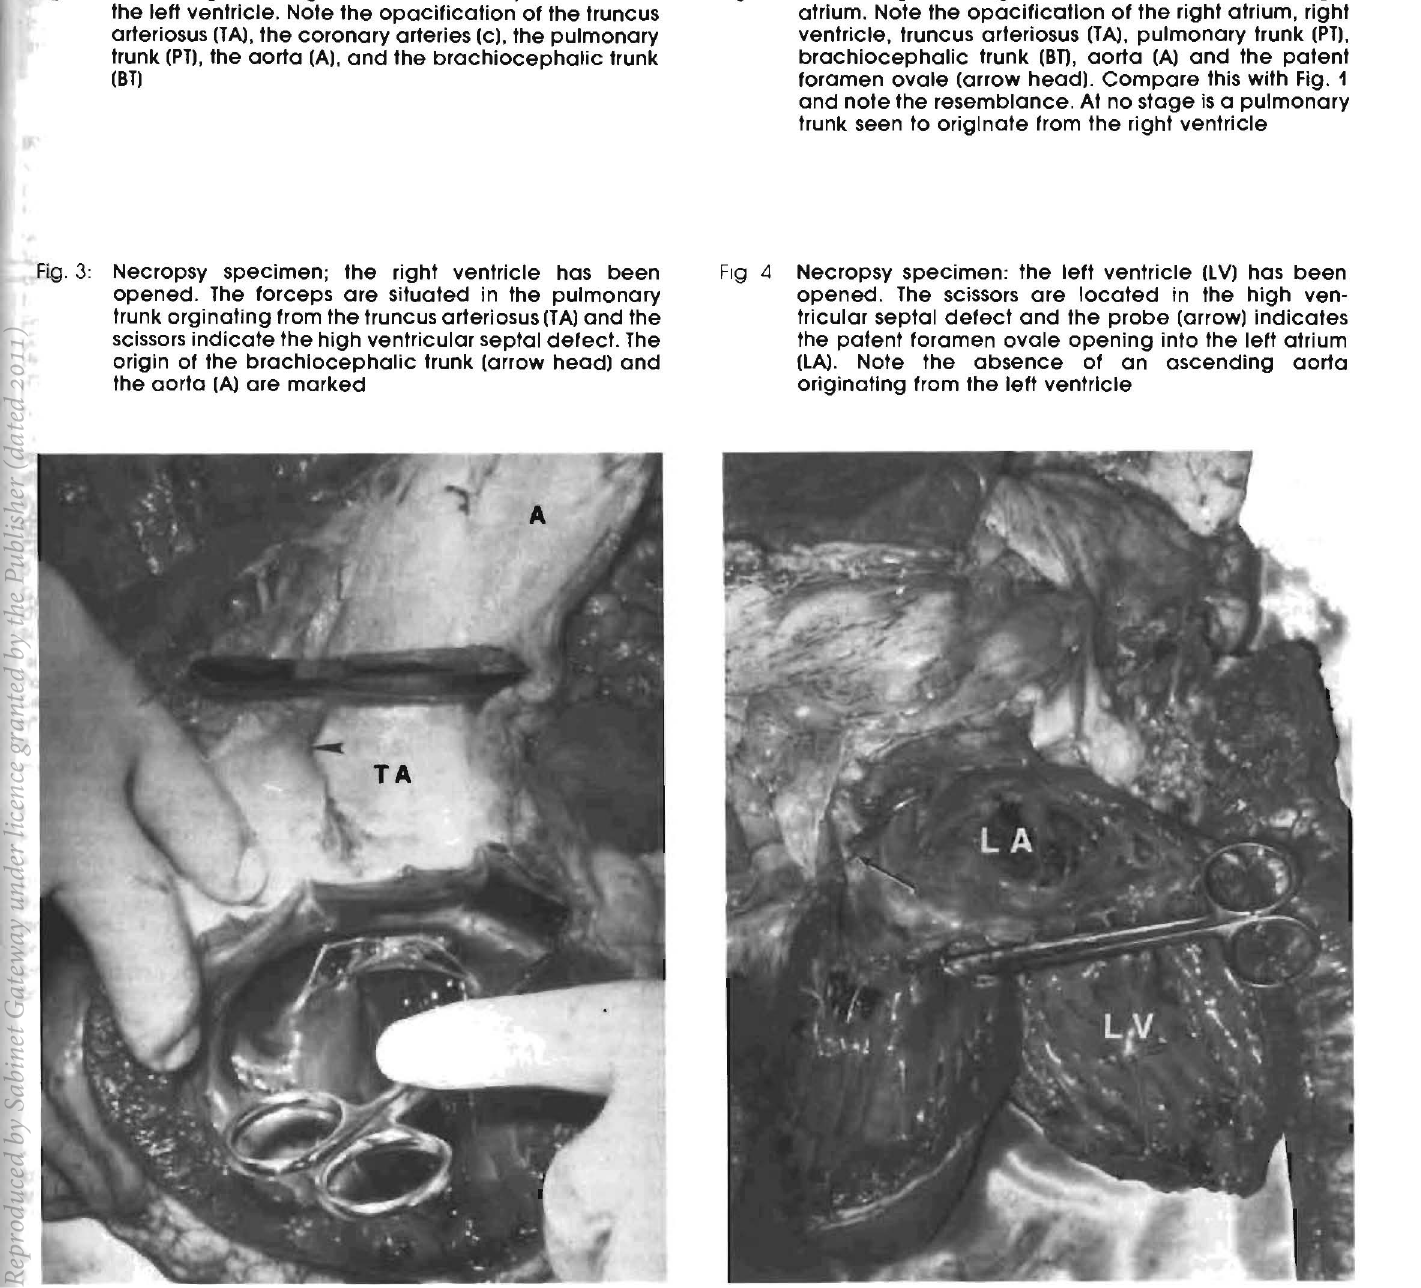
Fig. 1: laevo-angiocardiogram: the catheter tip is situated in the lett ventricle. Note the opacification of the truncus arteriosus (TA). the coronary arteries (c). the pulmonary trunk (PT). the aorta (A), and the brachiocephalic trunk (BT)